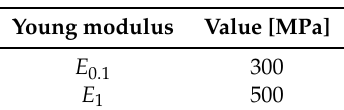
Table 4. Young modulus of the oocyte in the finite element (FE) model for injection speed of 0.1 mm/s and 1 mm/s